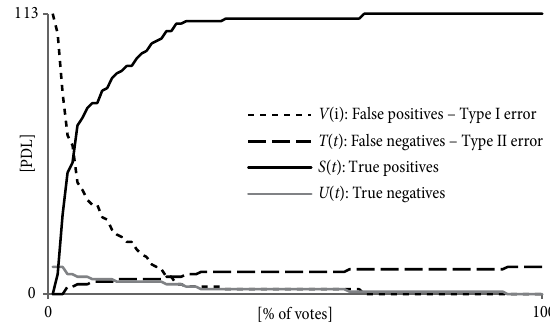
Fig. 1. The outcomes of the multiple hypothesis testing